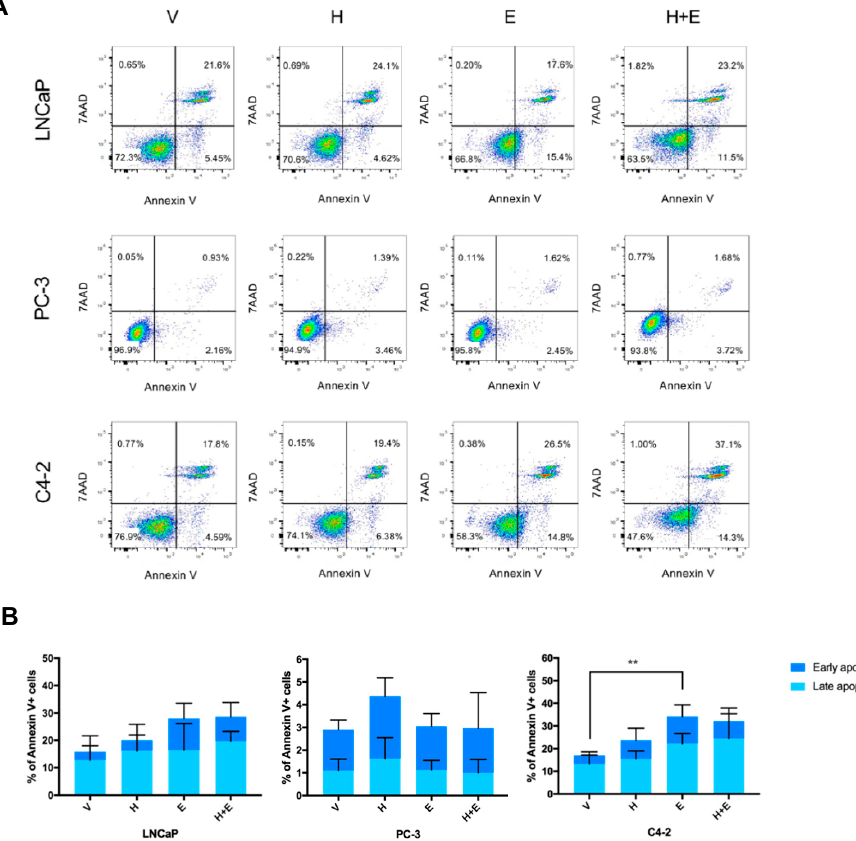
Figure 4. The combination of hydralazine and enzalutamide induced apoptosis in LNCaP and C4-2, but not in PC-3 cells. Representative Annexin V/7AAD dot plots ( A ) and data quantification ( B ). (V—vehicle, H—hydralazine, E—enzalutamide, H+E—combination of hydralazine and enzalutamide).